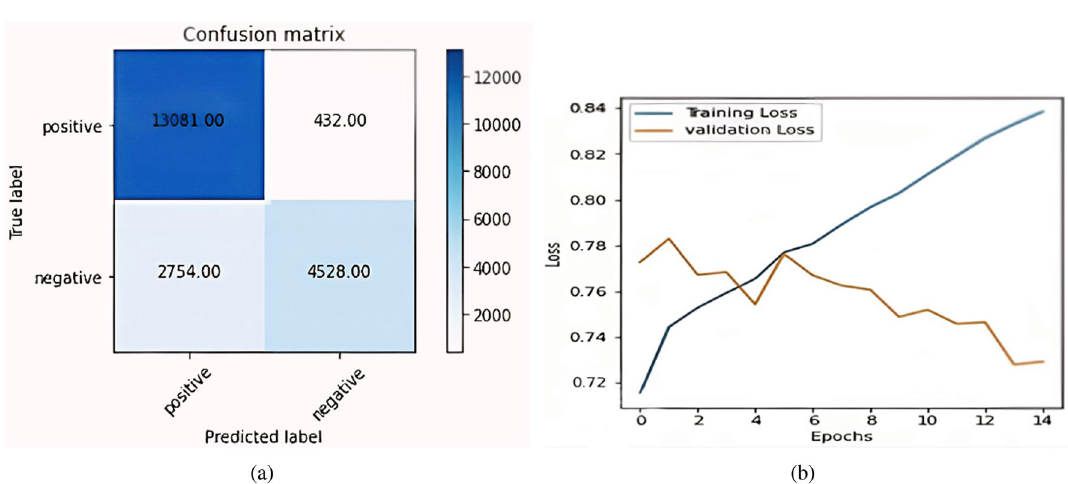
Figure 7. BERT Plus LSTM ( a ) Confusion matrix BERT plus LSTM; ( b ) BERT plus LSTM accuracy